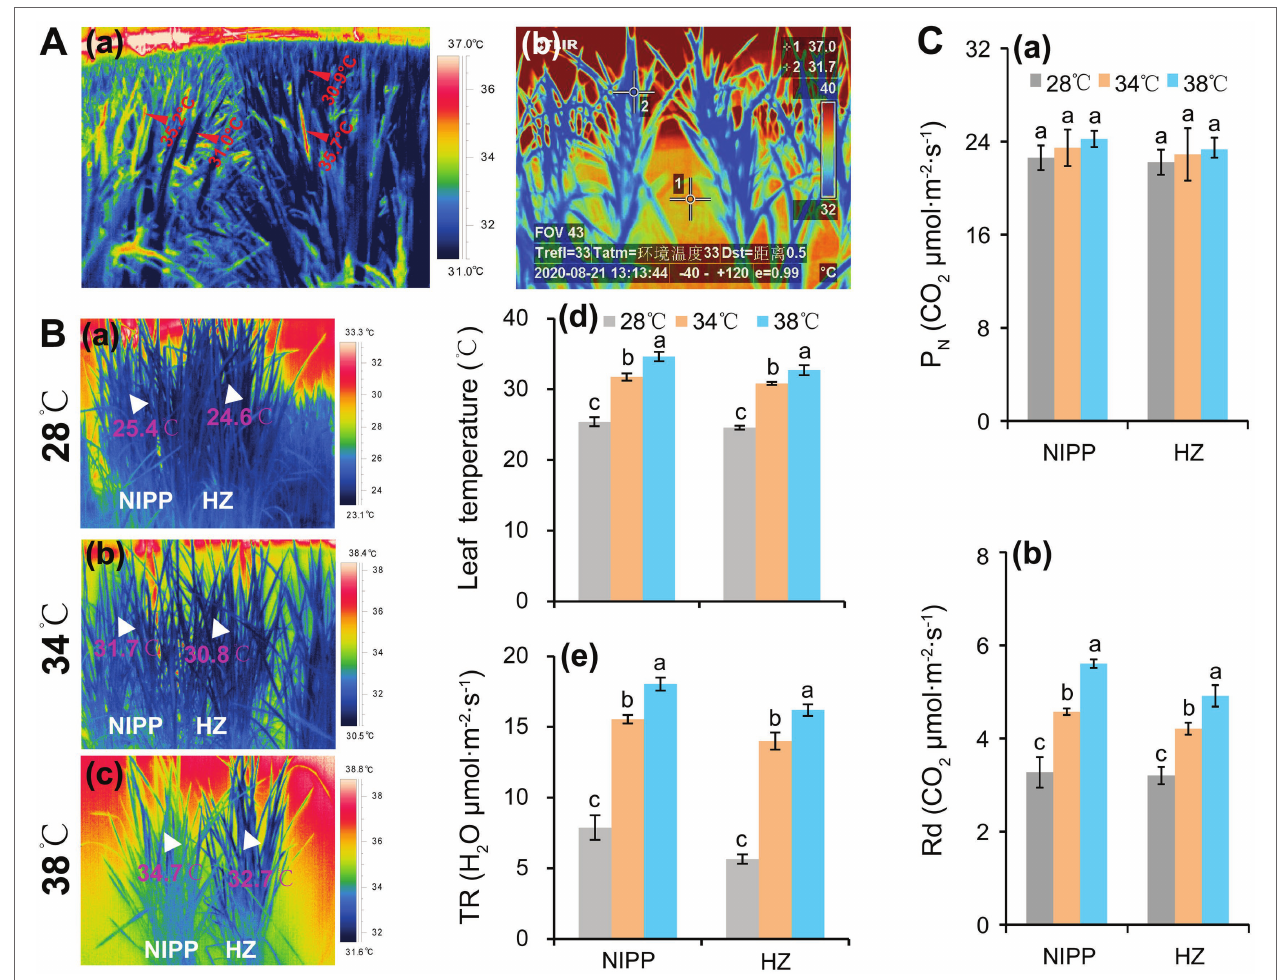
FIGURE 1 | Response of rice plants to high temperatures. (A) Changes in leaf temperature of rice plants under high temperatures: (a) Panicle and leaf temperatures of rice plants grown in the paddy field under a high temperature of 37–38 ° C at the anthesis stage; (b) Leaf temperatures of rice plants grown in a greenhouse under a high temperature of 41 ° C at the tillering stage. (Ba–c) The thermal images of rice plants under 28, 34, and 38 ° C conditions in plant growth chambers; (Bd) Leaf temperature; and (Be) Transpiration rate (TR). (Ca) Net photosynthetic rate (P N ); (Cb) Day respiration